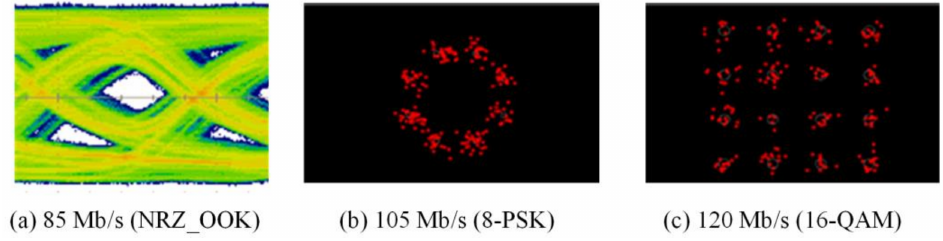
Figure 11. Pure data transmission rate of Green LED with bandpass filter (BER = 10 − 3 ).